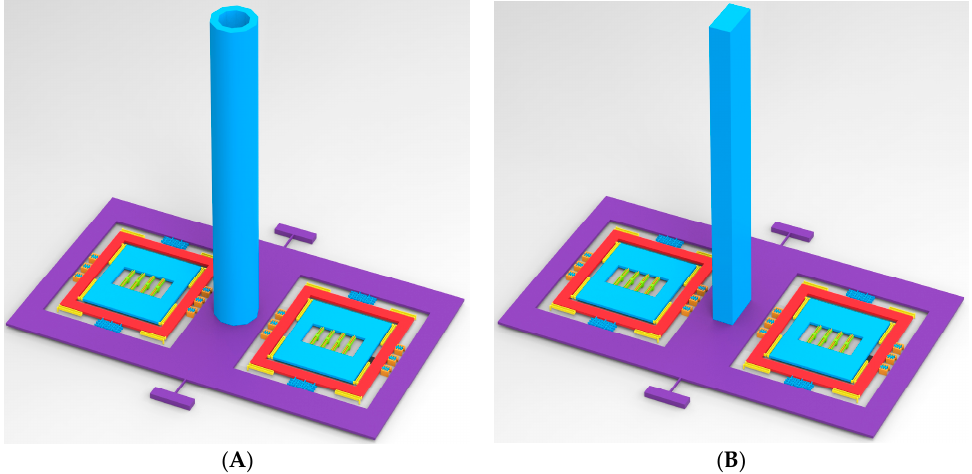
Figure 3. Different surface shapes of hair post for air flow rate sensitive optimization. ( A ) Hollow circular hair post; ( B ) Rectangle hair post.